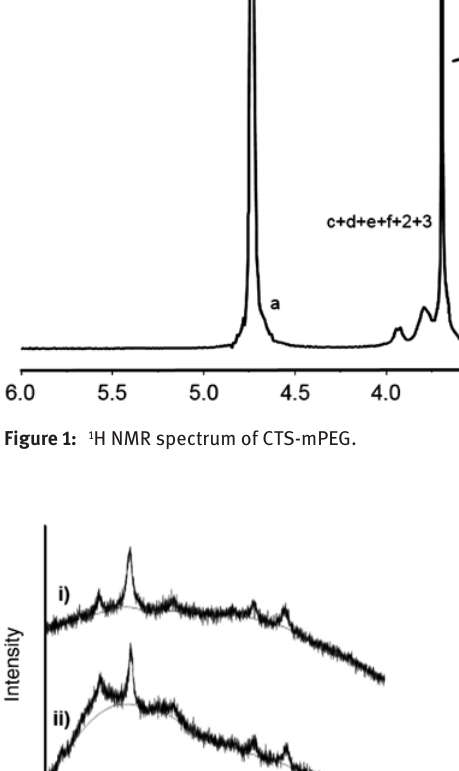
Figure 2: XRD patterns of (i) Fe